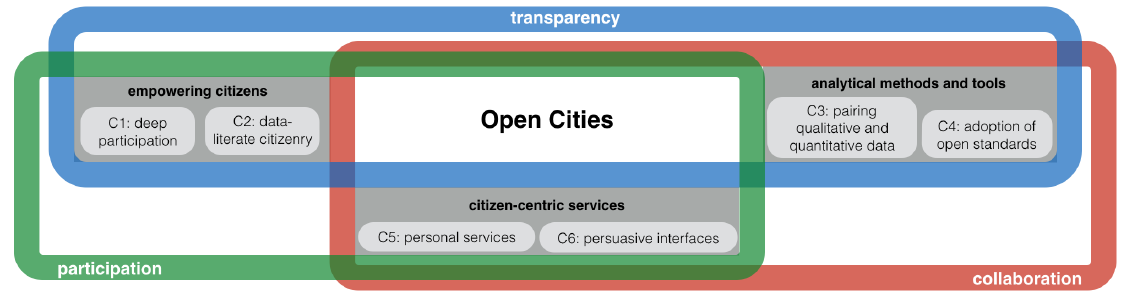
Figure 1. Citizen-centric challenges grouped into three research themes: empowering citizens, analytical methods and tools, and citizen-centric